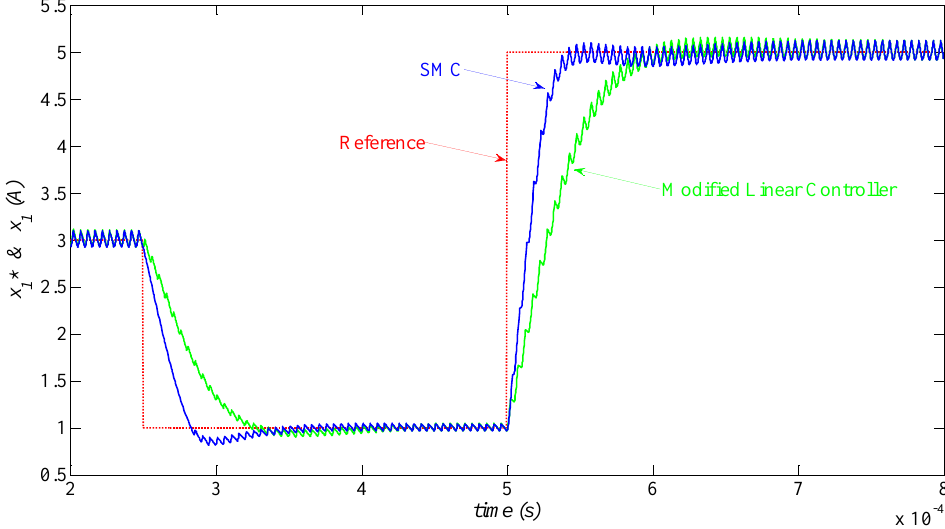
Figure 12. Step response of the developed controllers considering inductor’s ESR uncertainty .